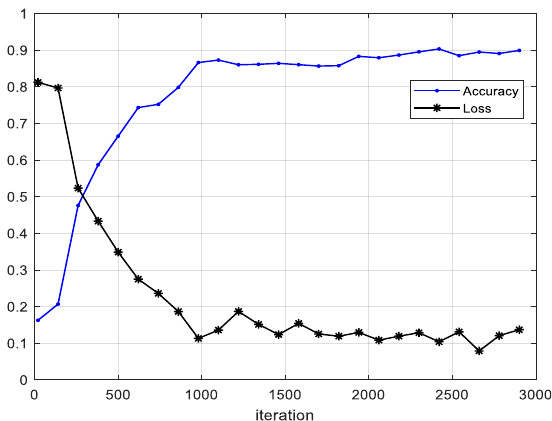
Figure 8. Accuracy and loss value versus iteration.